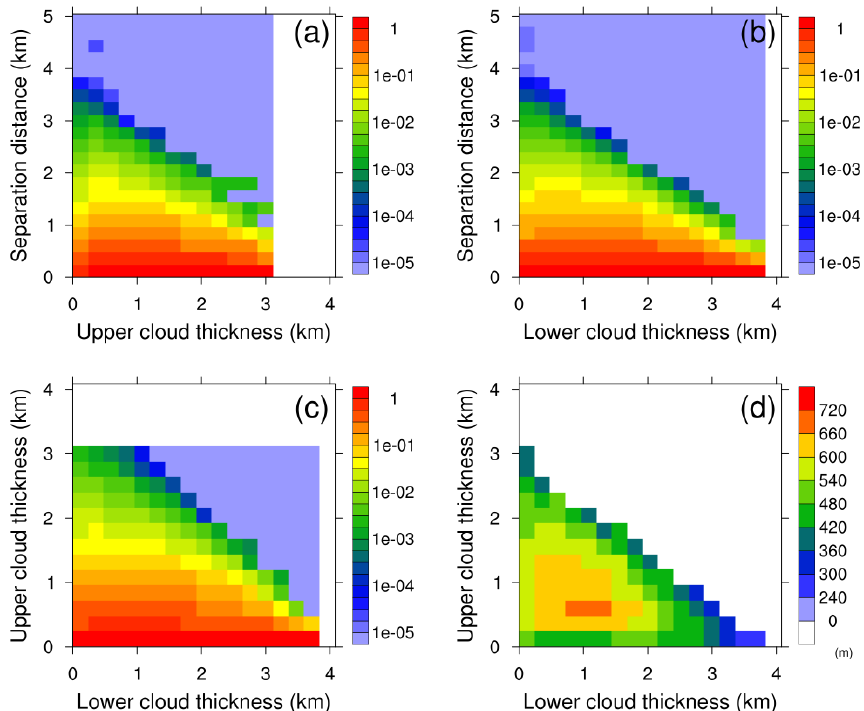
Figure 8. Sample frequency in the two-dimensional space of upper cloud thickness and separation distance ( a ), lower cloud thickness and separation distance ( b ), lower cloud thickness and upper cloud thickness ( c ), and the variation of separation distance depending on lower and upper cloud thickness ( d ), for warm-warm double layer clouds.